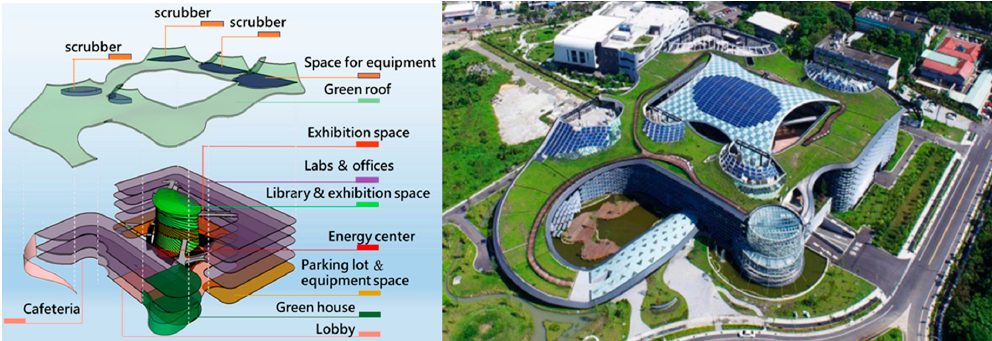
Figure 1. Design scheme and configuration space.